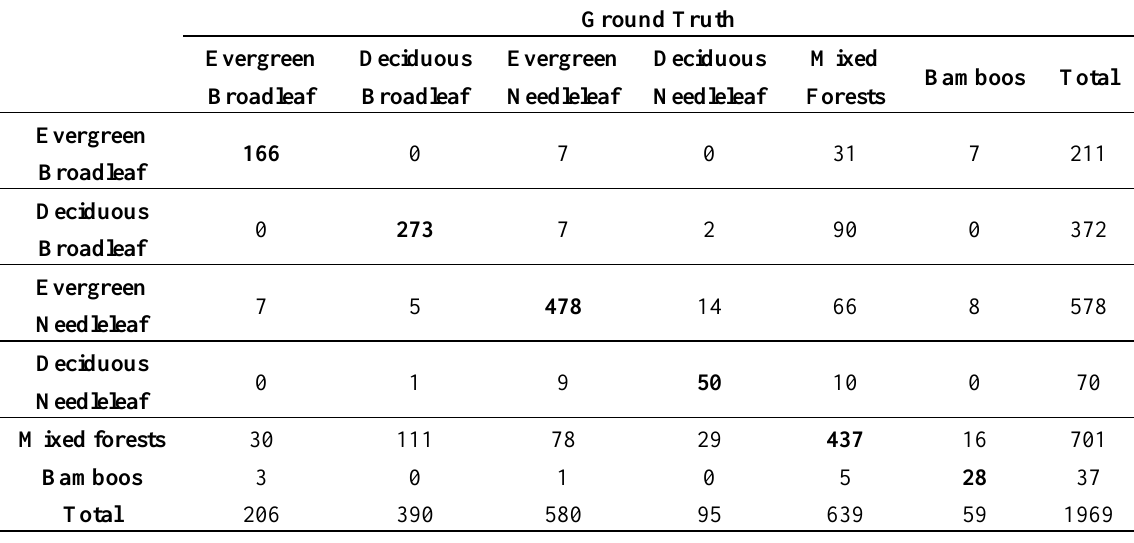
Table 4. The confusion matrix of Level-2 classification based on OOB